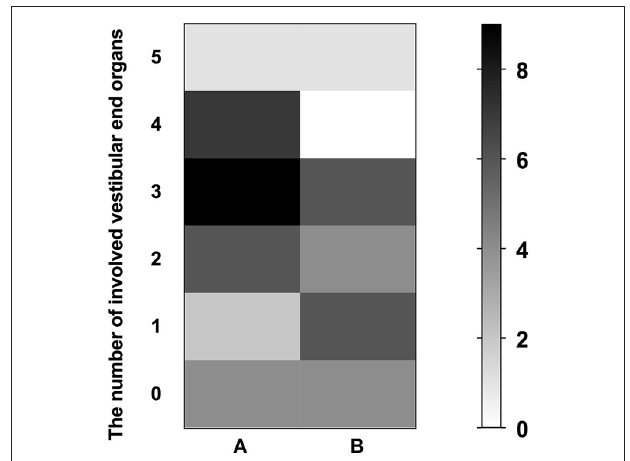
FIGURE 4 | The numbers of patients with involved vestibular end organs (VEOs) in the SSNHL vertigo group (A) and non-vertigo group (B) . The left ordinate represents the number of involved VEOs; the vertical axis on the right represents the number of patients.